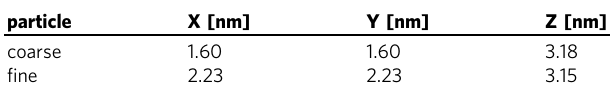
Table 2 Voxel dimensions in X-, Y- and Z-direction of the captured image stacks of both